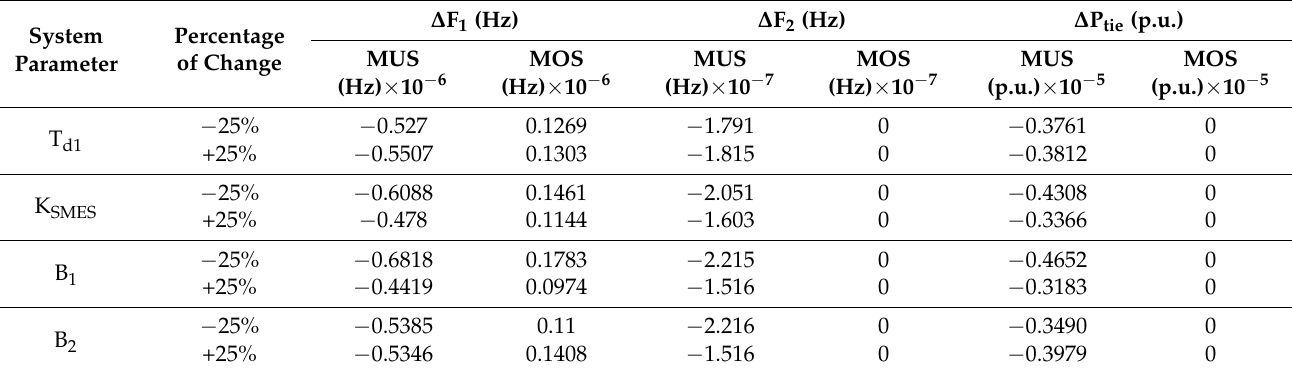
Table 6. Transient specifications based on ULC-fuzzy PIDF controller for system parameters